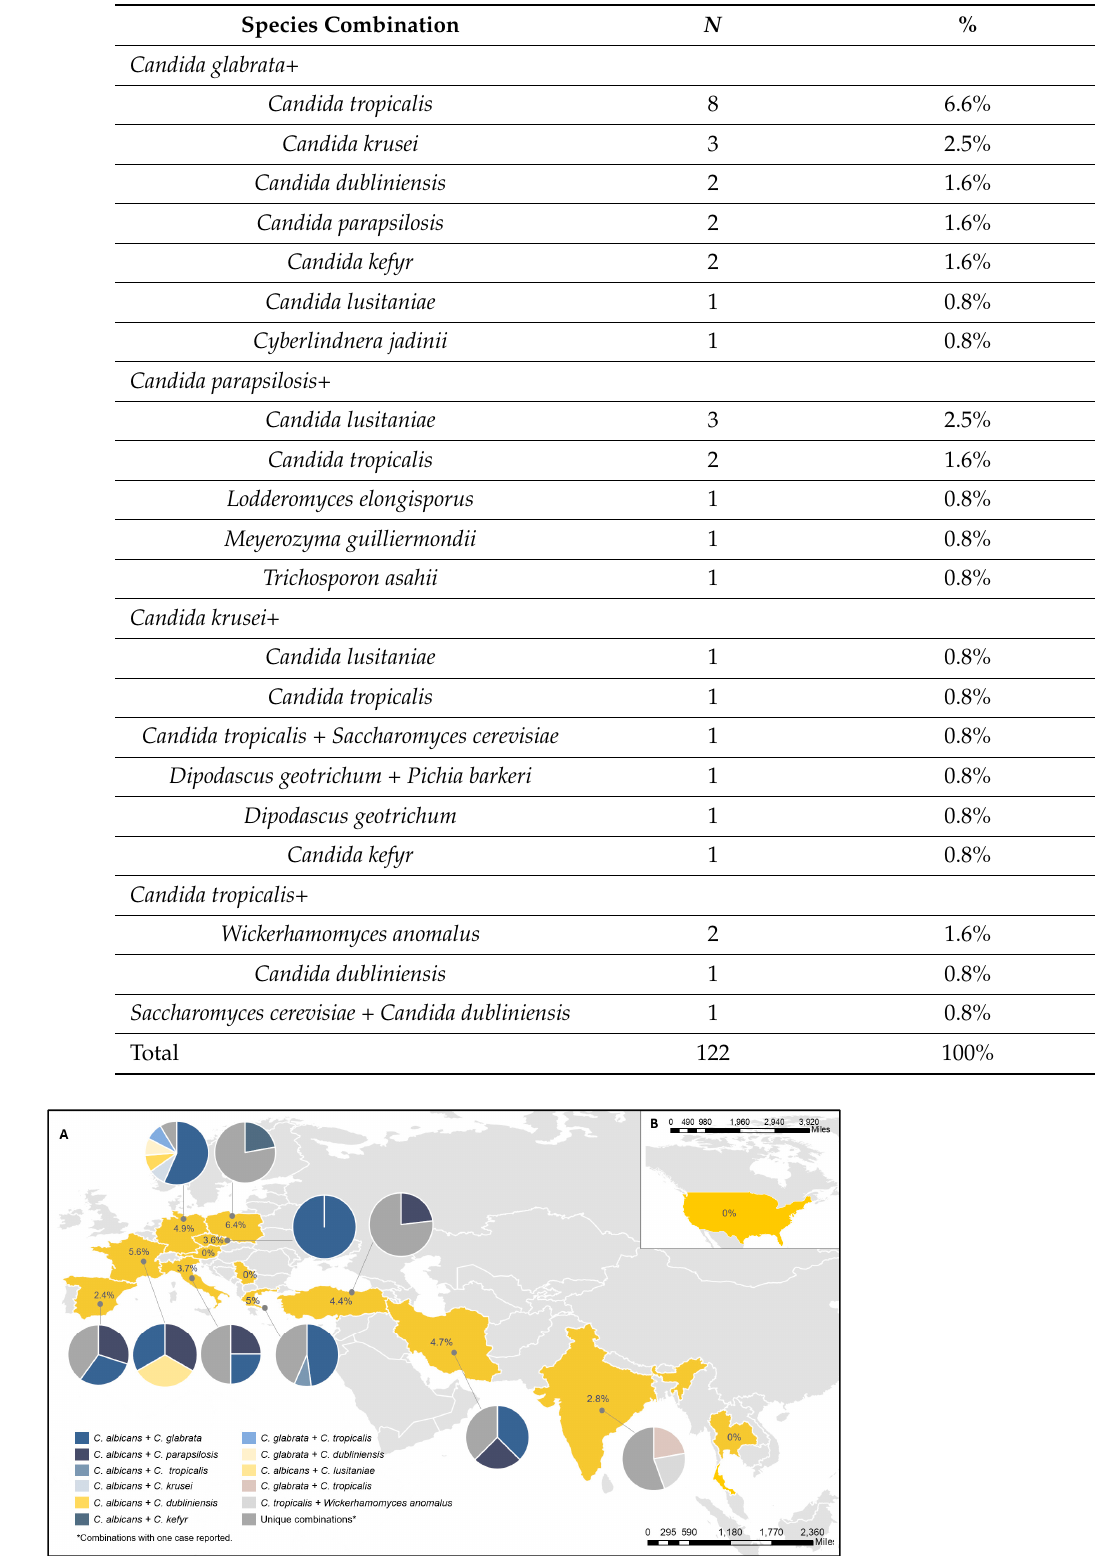
Figure 1. Rates, numbers, and species combinations found per country. ( A ) MY cases in Europe and Asia. ( B ) MY cases in the United States. The percentages shown inside each country represented the rate of MY per positive yeast cultures in each country and pie charts represent the MY combinations for each country.